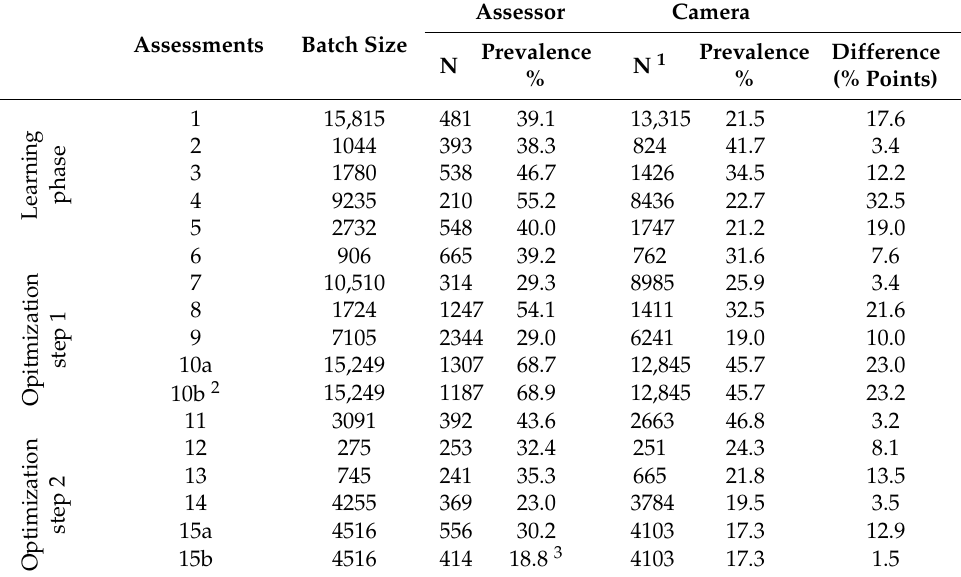
Table 4. Prevalence (%) of keel bone damage in laying hens at the slaughter line assessed by a trained person and an automated camera system and differences between the determined prevalences (%